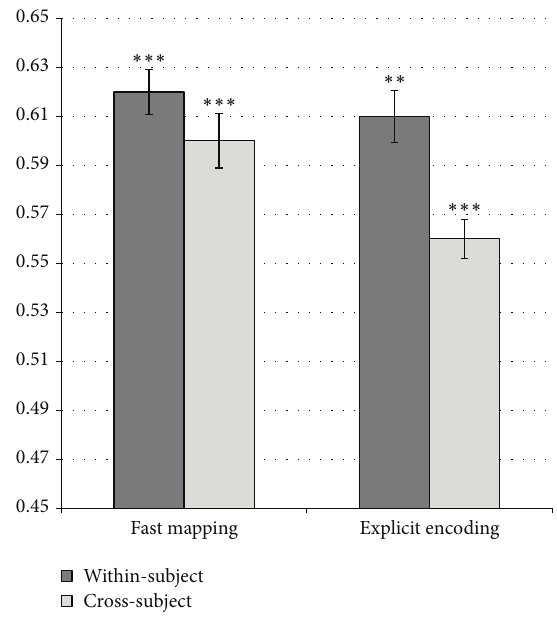
Figure 2: Classification accuracy for within-subject and cross- subject validation procedures. Error bars represent standard error of the mean. ∗∗∗ 𝑃 < 0.001 ∗∗ 𝑃 < 0.01 , permutation